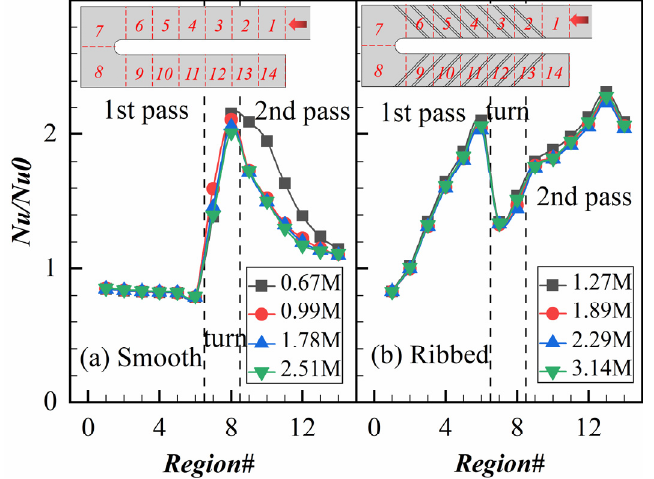
Figure 4. Mesh independence verification in smooth/ribbed channels under stationary condition.